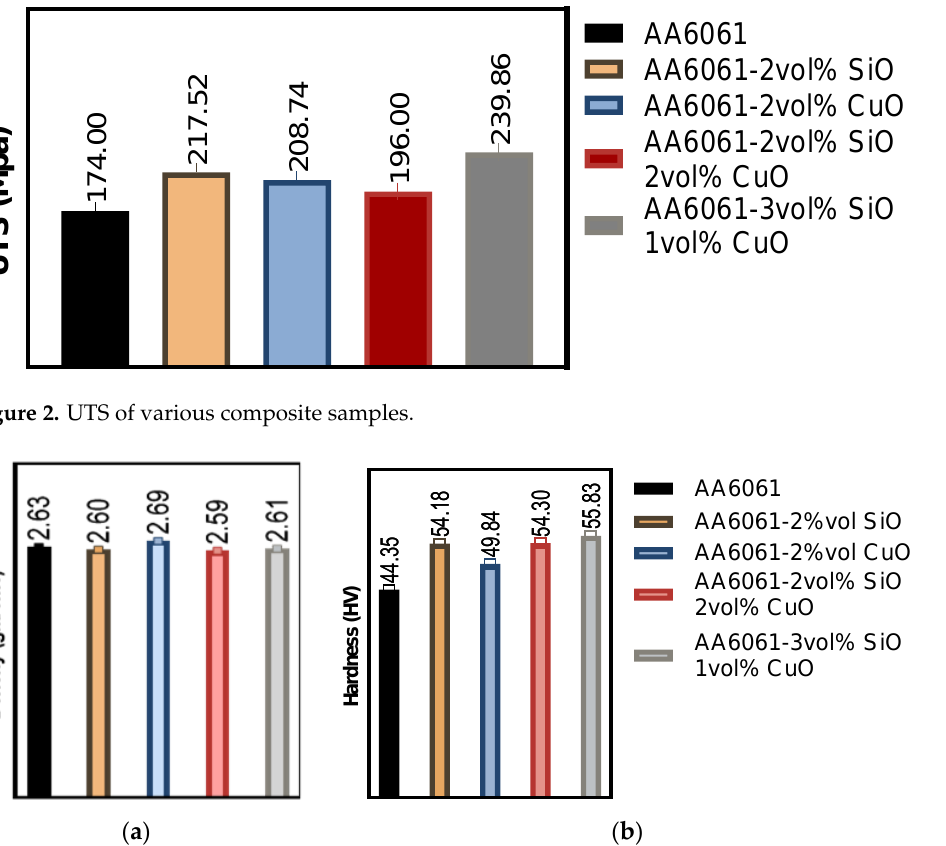
Figure 3. Composite samples, ( a ) density and ( b ) hardness.